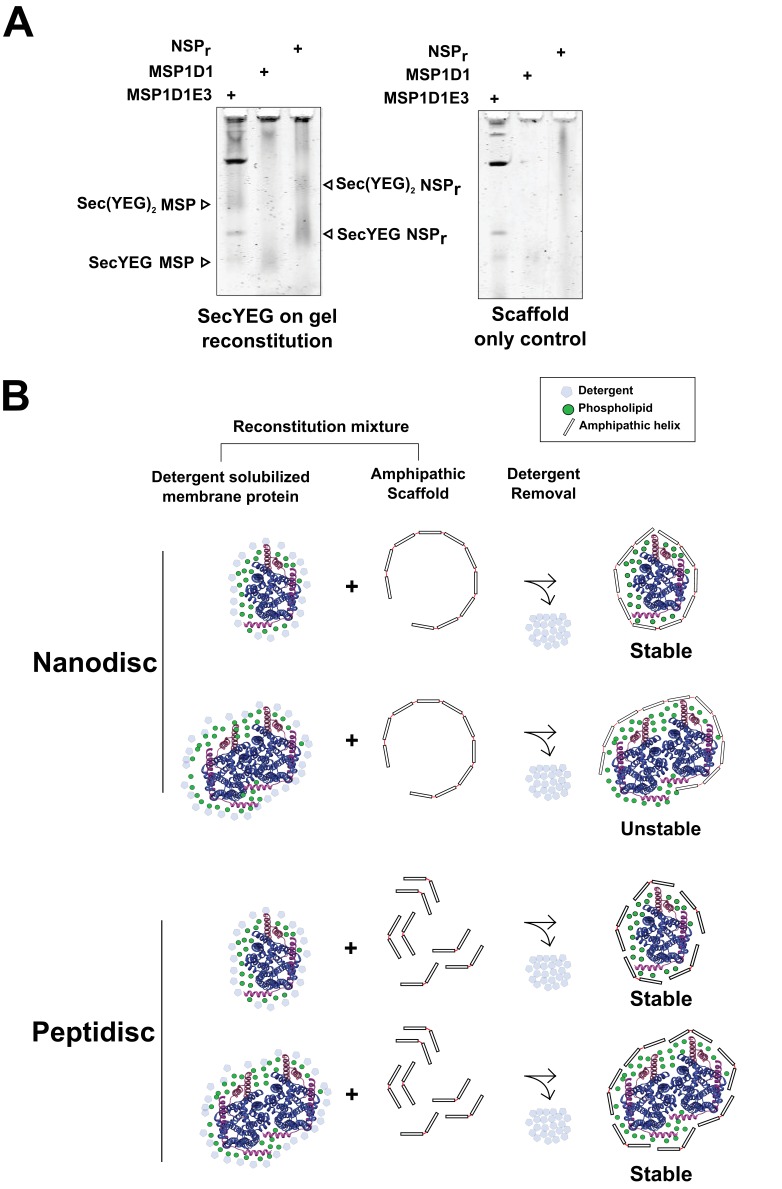
Capture of SecYEG monomer and dimer in peptidisc and nanodisc.(A) Left panel; the SecYEG complex (2.5 µg) was incubated with the indicated scaffolds proteins (1.25 µg each) in Buffer A + 0.02% DDM. The sample was diluted threefold in detergent-free Buffer A and immediately analyzed by CN-PAGE. Right panel; the experiment on left panel was performed without addition of SecYEG. (B) Illustration representing possible reconstitution products of the SecYEGn complex into MSP1D1 and NSPr. The subunits SecY, SecE, and SecG are represented as blue, pink, and magenta, respectively.